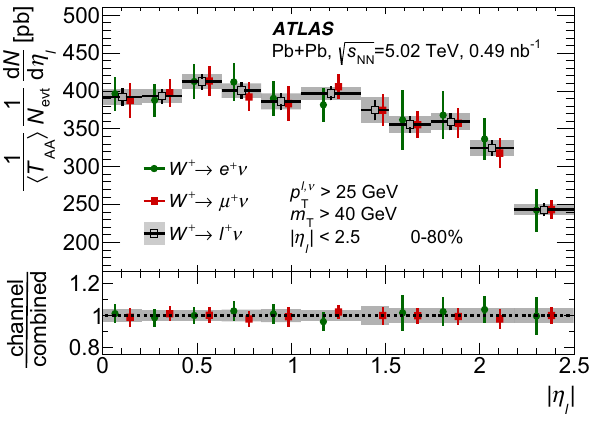
error bars. Systematic uncertainties related to (cid:4) T AA (cid:5) are not included. The lower panels show the ratios of channels to combined yields in each bin with error bars and shaded boxes representing the total uncertain- ties of the channels and combined yields, respectively. The points for individual channels are shifted horizontally for better visibility